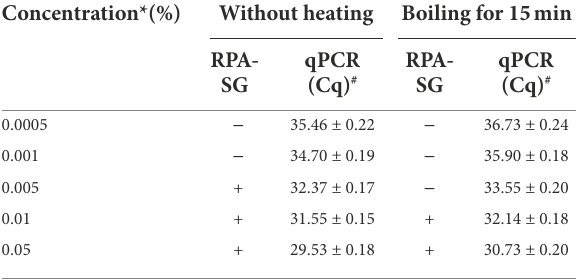
“+” = positive results, “–” = negative results. *Marine fish samples were spiked with different concentration of anisakid larvae (w/w). # The data are presented as mean ± standard deviation (SD). Each concentration had three